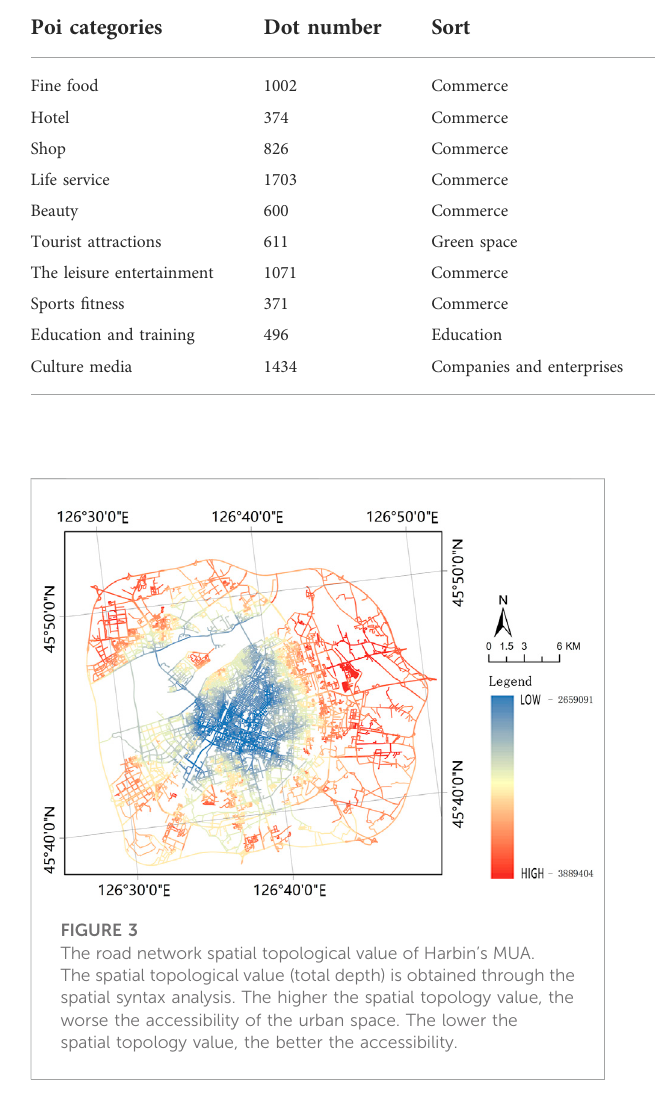
(Table 1). According to the research of Liu and Long (2016), the selected data are divided into eight categories: government